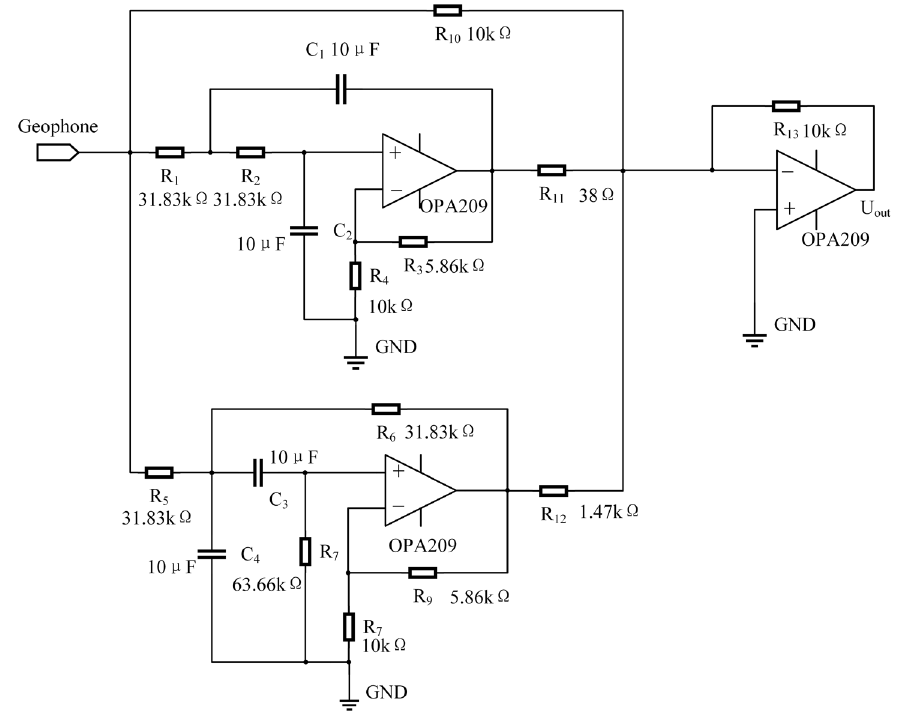
Figure 4. Zero-pole compensation circuit diagram.